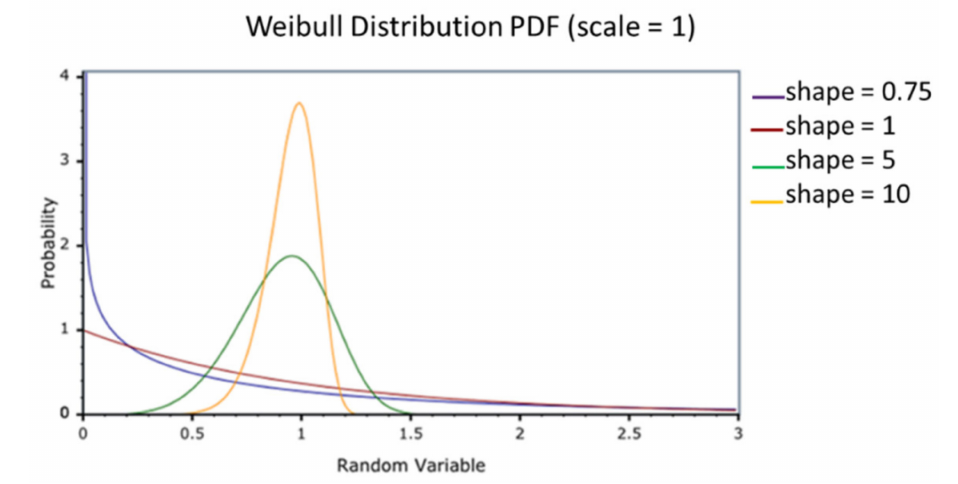
Figure 1. Weibull distribution for different shape parameters ( k ).